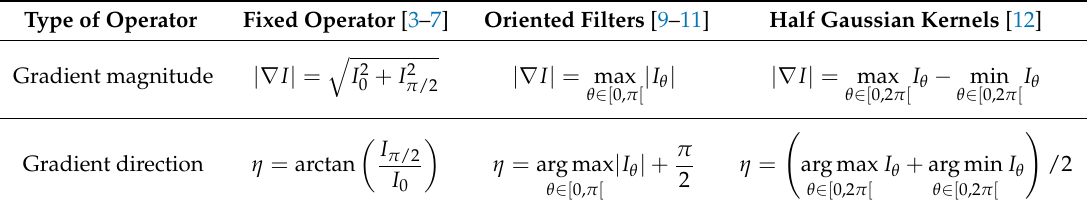
Table 1. Gradient magnitude and orientation computation for a scalar image I , where I θ represents the image derivative using a first-order filter at the θ orientation (in